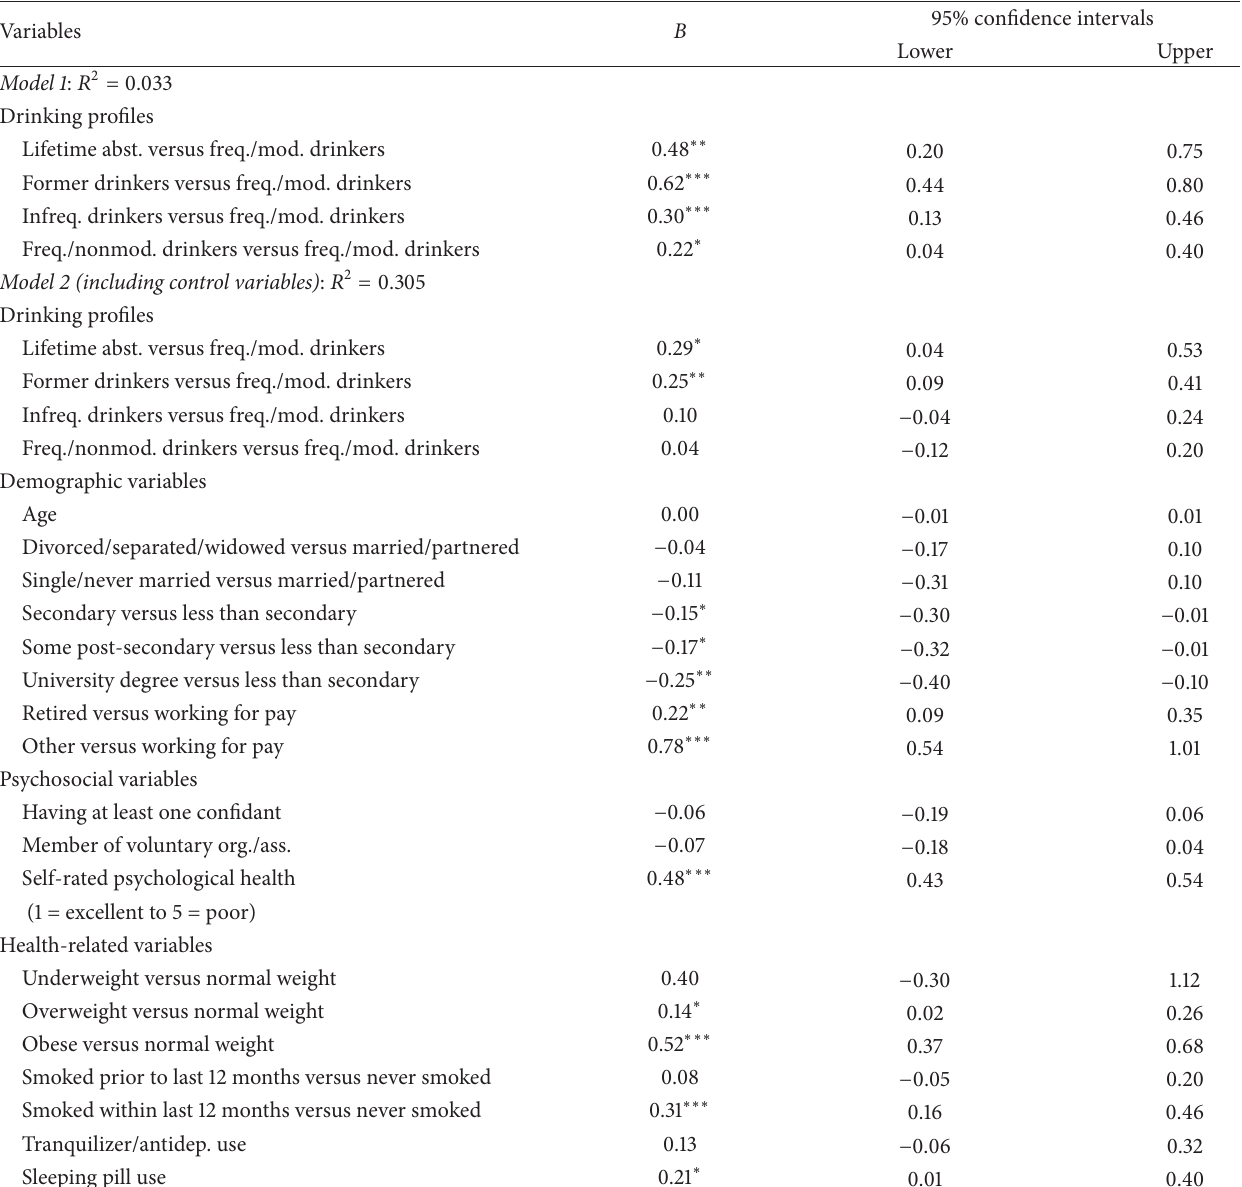
Table 3: Regression analysis of self-rated health among men, 55–74 years of age ( 𝑛 =